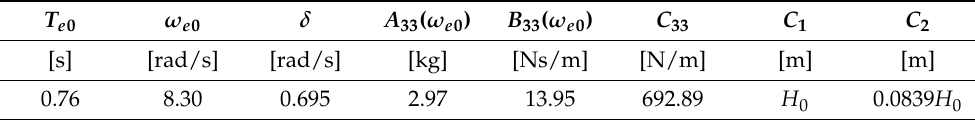
Table A2. Hydrodynamic coefficients and modal parameters utilized in the LPF0 model.